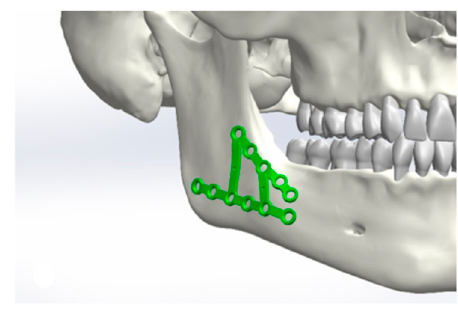
Figure 3. Positioning of the osteosynthesis plates in the area of the angle.